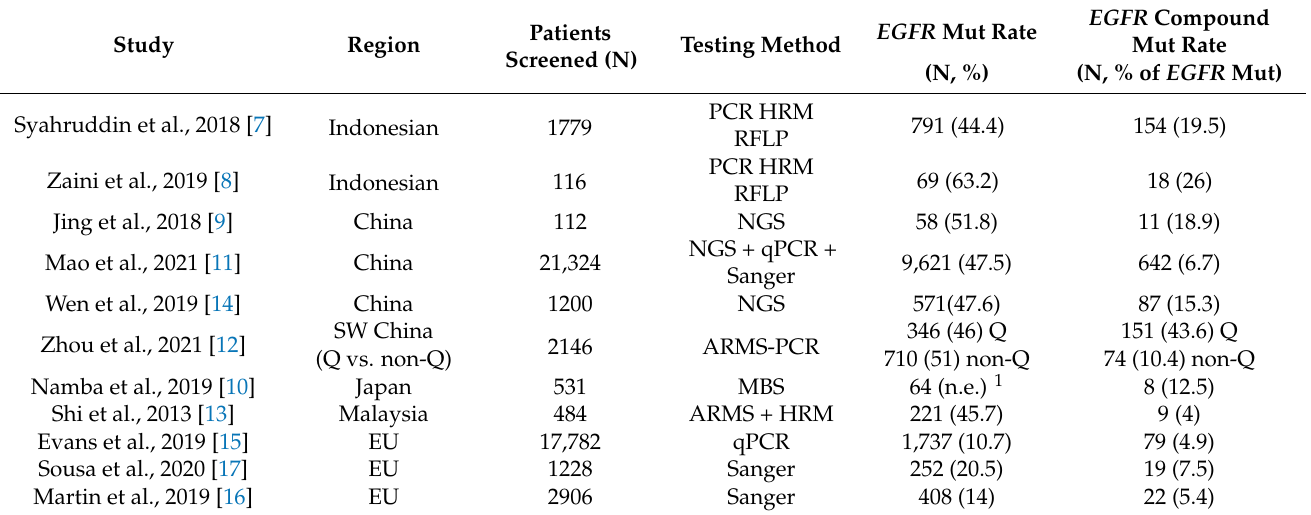
Table 1. Main studies reporting the testing rate of EGFR compound mutation in NSCLC tissue